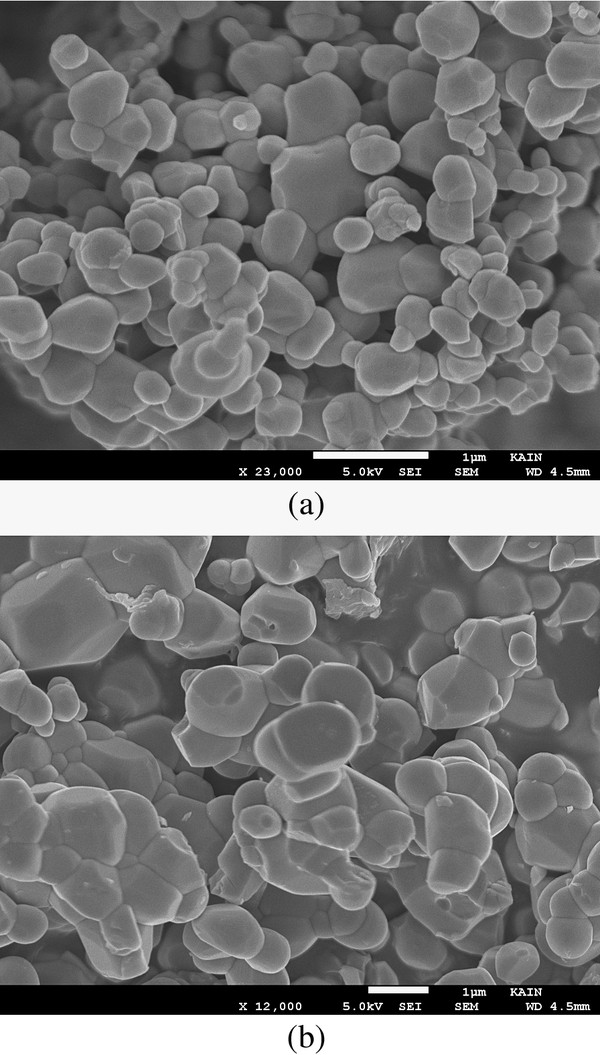
FE-SEM images of the Bi4 −xNdxFeTi3O12forx = 0.0 (a) and 0.05 (b) compositions.